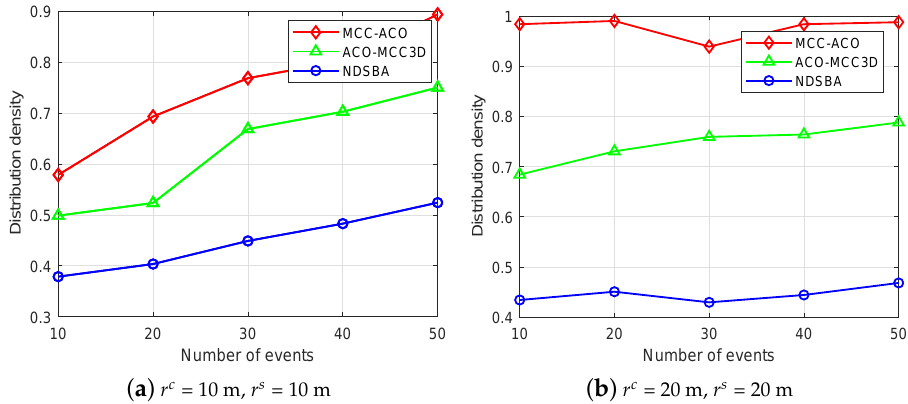
Figure 8. Comparison of the distribution density of the deployed nodes for different numbers of